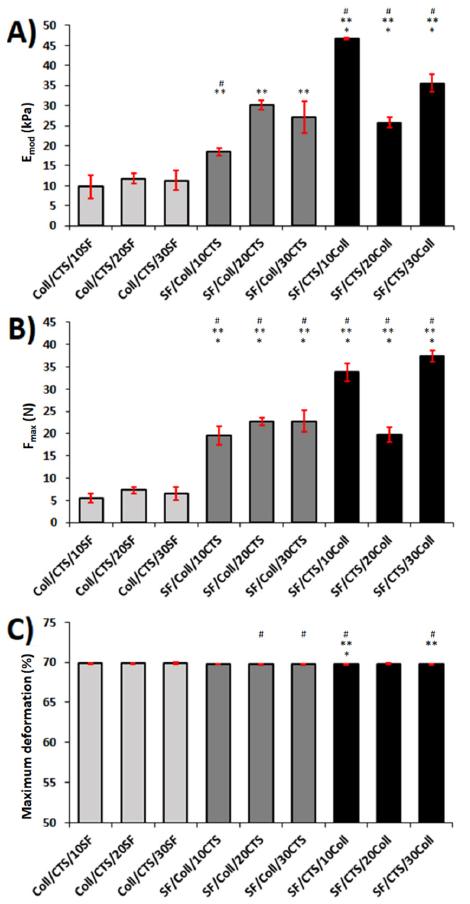
Figure 8. Results (( A ) Young’s modulus, ( B ) maximum force, and ( C ) maximum deformation) of the mechanical testing in room conditions (temperature and humidity) for each kind of scaffold ( n = 5, mean ± SD, * significantly different vs. Coll/CTS/10SF, ** significantly different vs. Coll/CTS/20SF, # significantly different vs. Coll/CTS/30SF, p < 0.05).